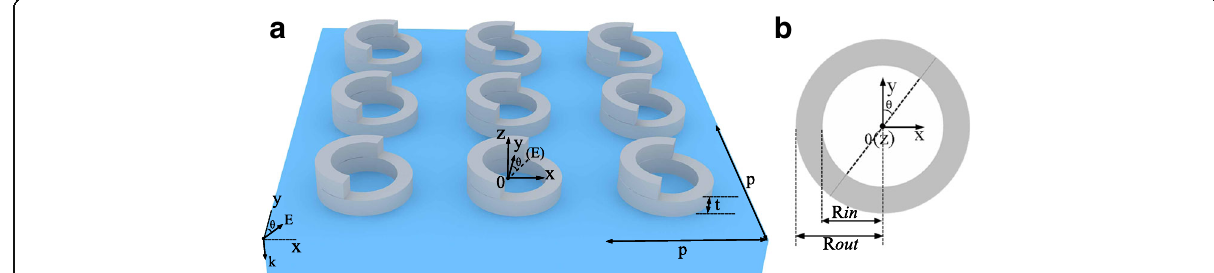
Fig. 1 a Schematic diagram of the silver nanoring/half nanoring, the geometric parameters are R in = 310 nm, R out = 400 nm, t = 40 nm and p = 1000 nm. b The top view corresponding to the single cell of nanostructure is arranged right. The orientation angle of the half nanoring shifting from the axle wire (along the y -direction) of the concentric system is